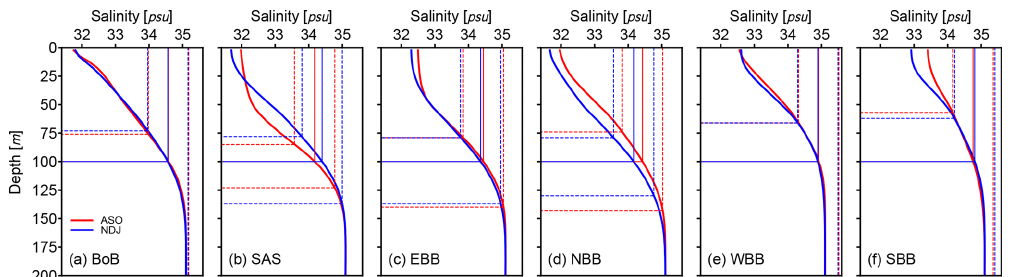
Figure 11. Domain-averaged climatological vertical salinity profiles of the BoB (a) and subareas (b, c, d, e, f) during ASO (red thick line) and NDJ (blue thick line). Solid thin lines with corresponding colors indicate the salinity of 100m. Dashed thin lines with corresponding colors indicate the equivalent vertical displacement, yielding a 0.6psu salinity